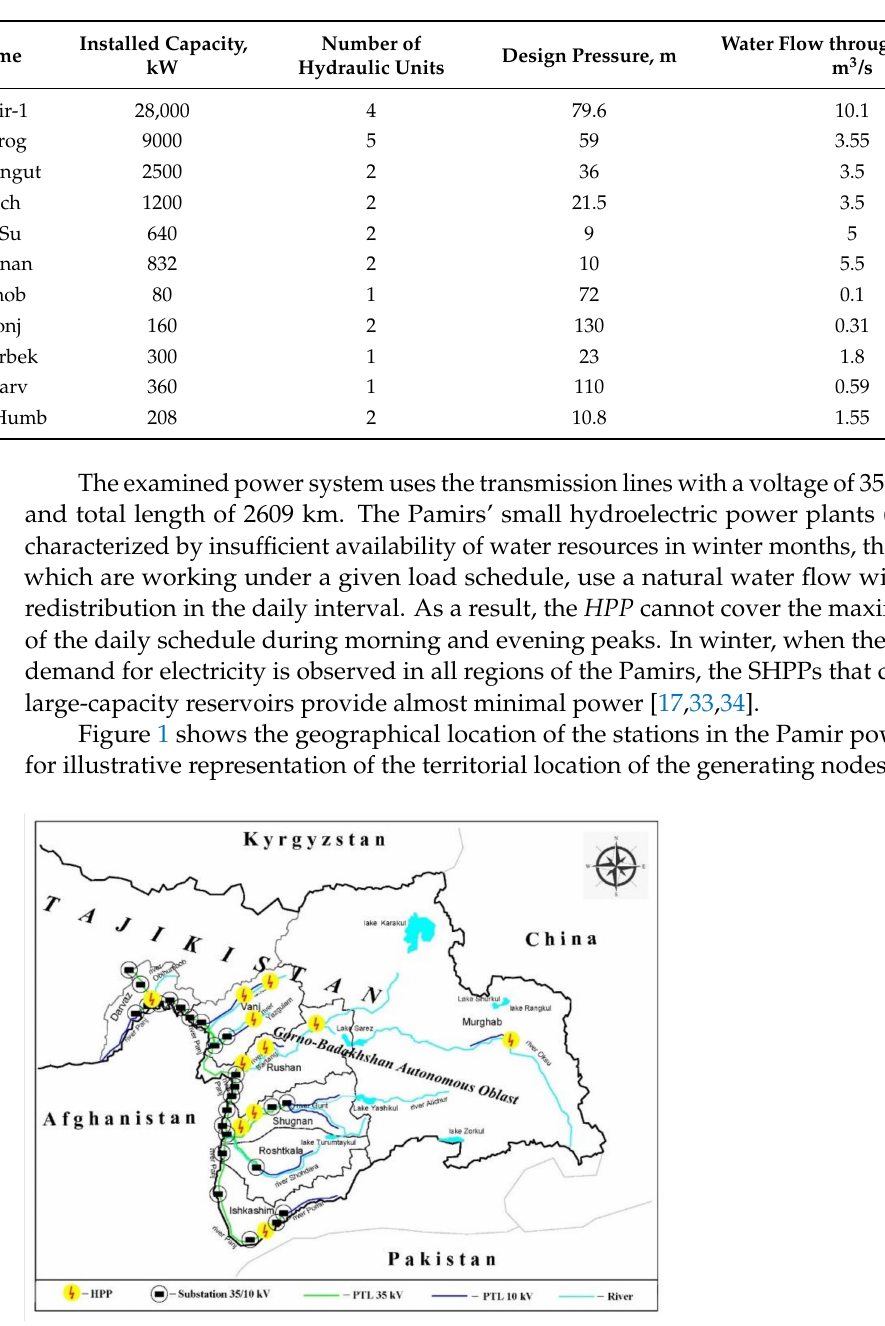
Table 1. Information about the SHPP located on the territory of GBAR.